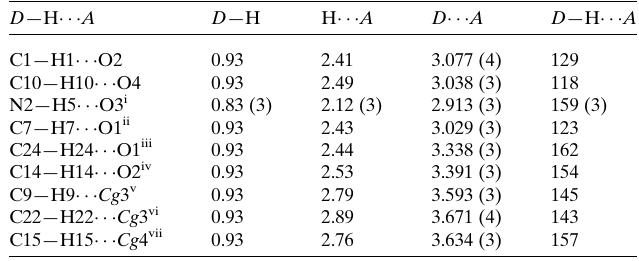
Table 2 Hydrogen-bond geometry (A˚ , (cid:3)